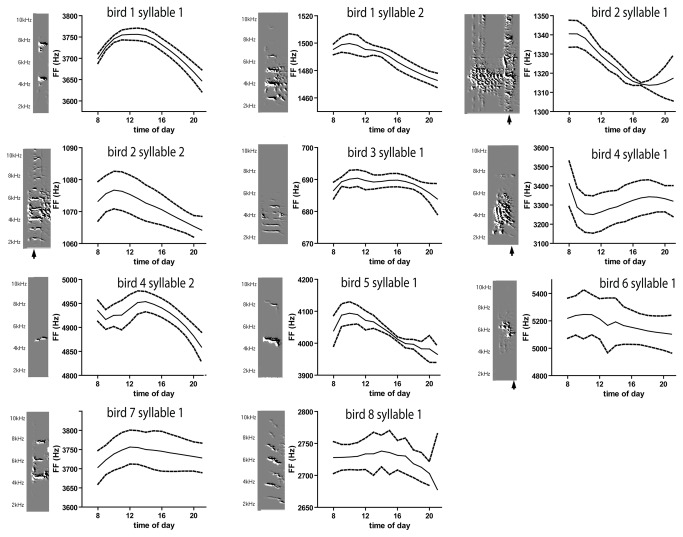
FF of harmonic stacks, and of harmonic subsyllabic elements, follows a daily oscillation, albeit with substantial variation and noise.Averaged daily RLOESS fits of FF (± 1 SD) for 11 syllables from 8 animals. Average number of days = 13.25 ± 7.025.